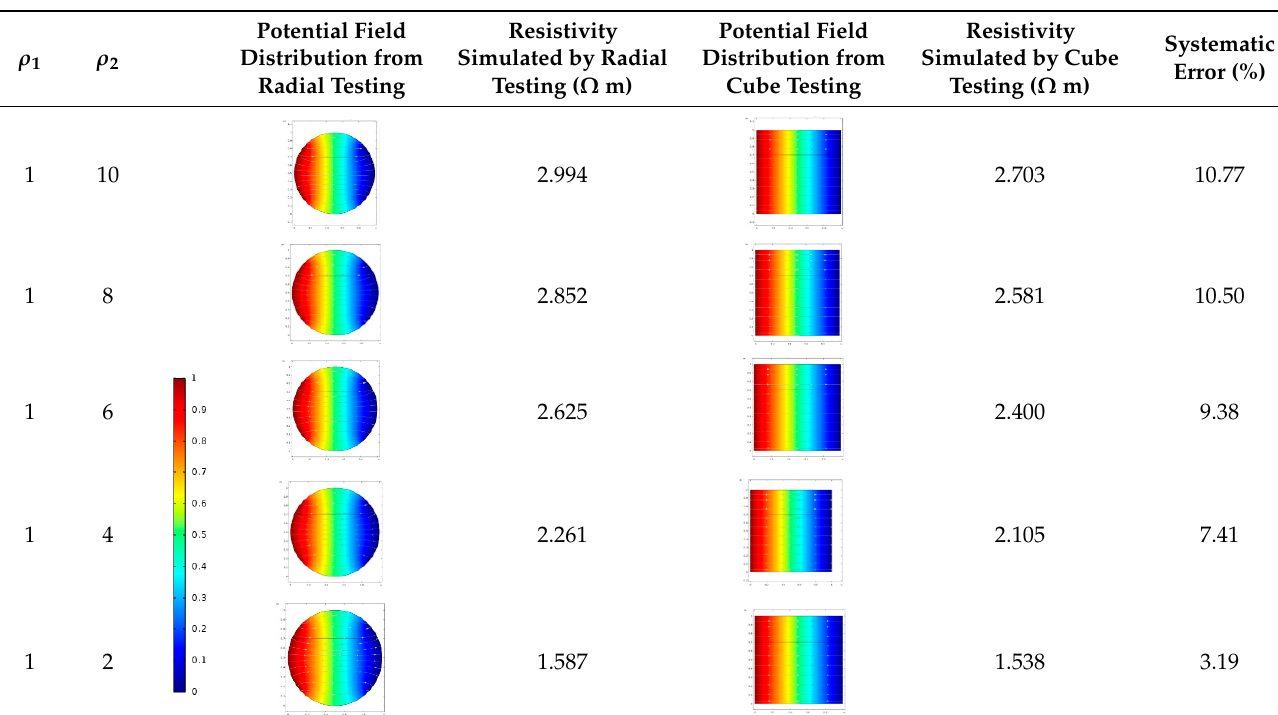
Table 8. Numerical simulation results for resistivity difference in various materials (0.3:0.7).